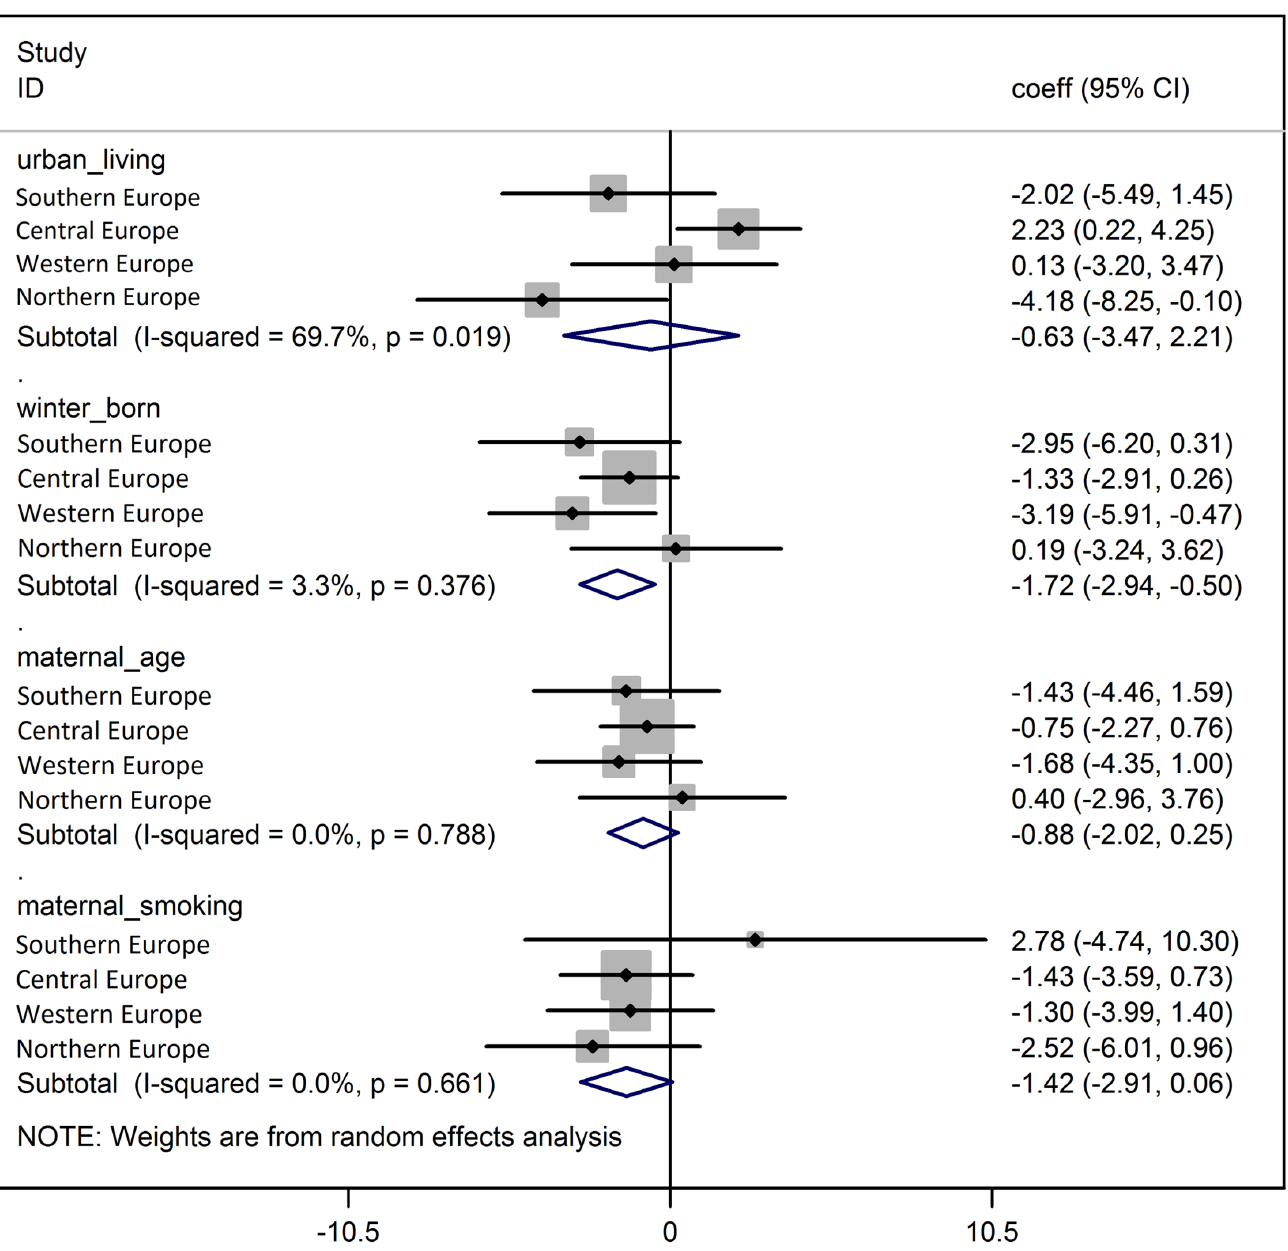
Fig 1. Meta-analyses across European regions: selected early life factors and FEV 1 decline. Δ FEV1/yr. corresponds to change in FEV1 (ml) per year of follow-up — a negative coefficient implies more rapid FEV1 decline and a positive coefficient implies less rapid decline Meta-Analyses by European region, mutually adjusted for all other early life factors investigated and for sex, mid age, mid age square, mid BMI, change in BMI (between survey 1 and 2), height, lifetime pack years smoked, age at highest education, study area (random